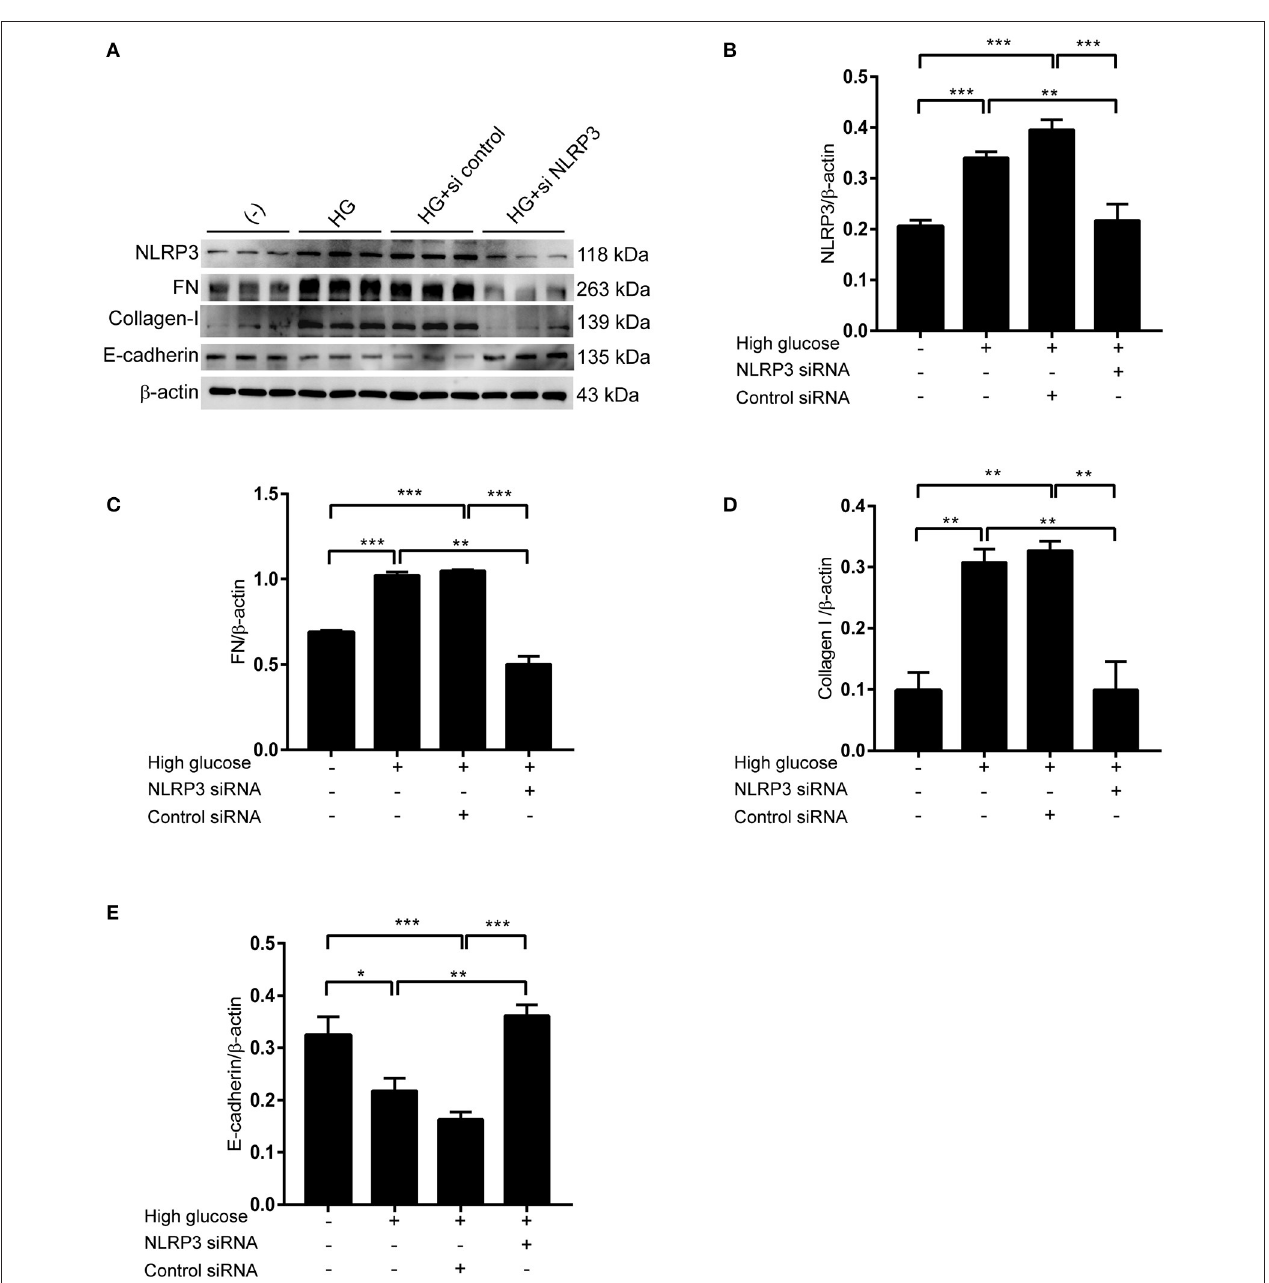
FIGURE 6 | Inhibition of NLRP3 by siRNA abrogates high-glucose-induced synthesis of extracellular matrix proteins in RBMCs. (A) RBMCs were treated with NLRP3 siRNA or control siRNA, followed by incubation with high glucose for 48h. Western blotting confirmed the expression of NLRP3, FN, Collagen-I, and E-cadherin. Quantitative analyses of NLRP3, FN, Collagen-I, and E-cadherin were displayed in the (B–E) . The data are represented as the mean ± SEM. * P < 0.05, ** P < 0.01, *** P < 0.001.